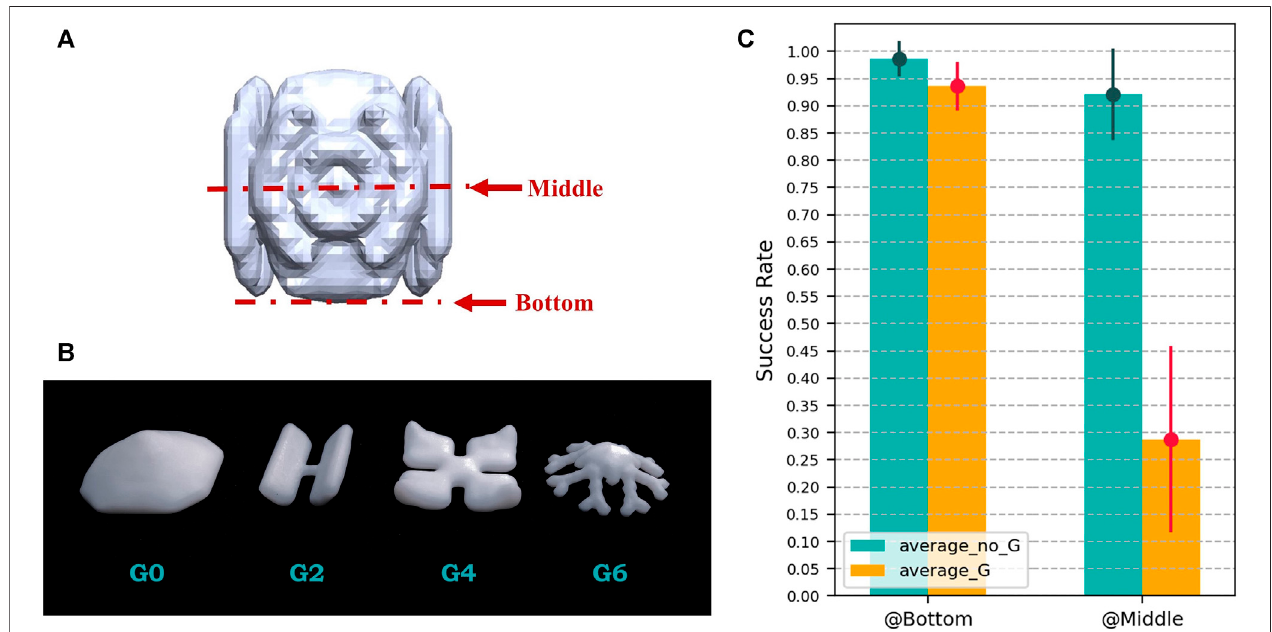
FIGURE6|(A) Graspsatdifferentpositionsoftheobject,middleandbottom. (B) “ G ” groupobjects,whichareallofthe fl atshape,challengingforroboticgrasping using the gripper, and are normally grasped using suction cup. (C) Grasping performance comparison between the grasping position at the bottom and middle of the